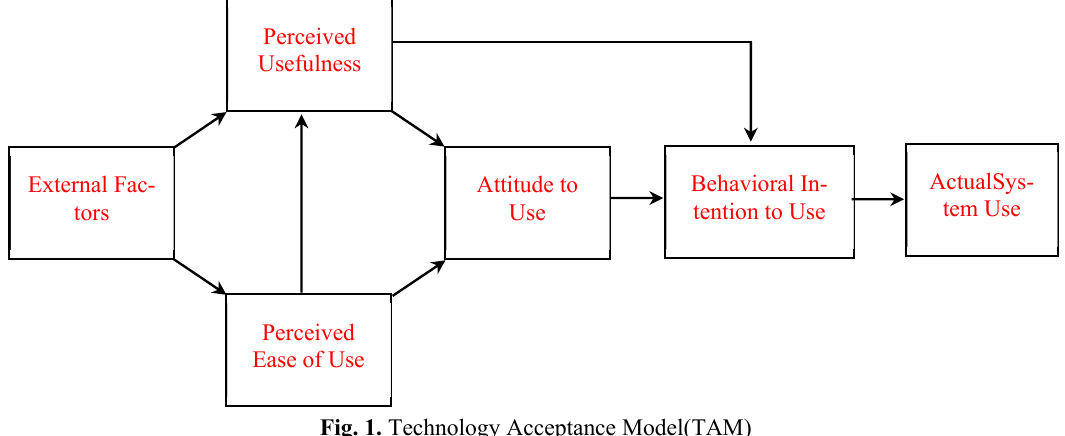
Fig. 1. Technology Acceptance Model(TAM) Source: Davis(1989); Yusoff et al.